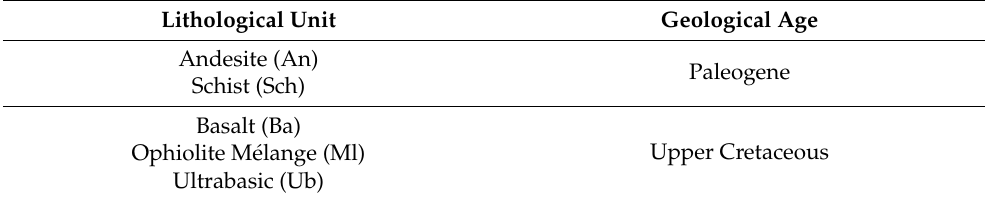
Table 2. Geological ages of host lithological units related to copper occurrences in the study